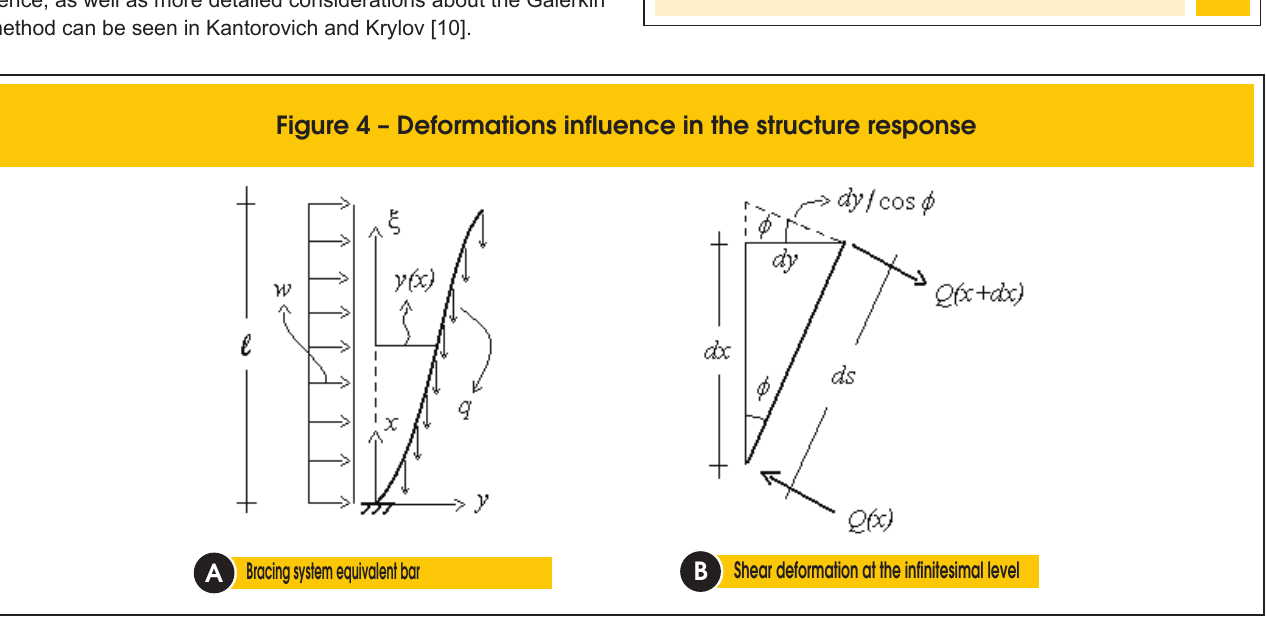
Bracing system equivalent bar Shear deformation at the infinitesimal level